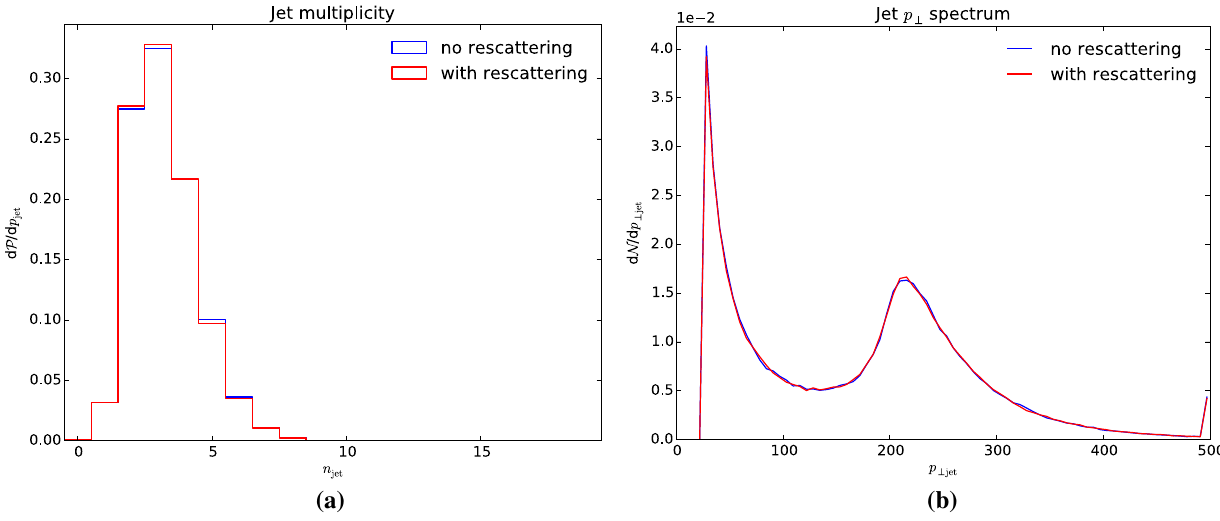
Fig. 9 Production rates ( a ) and inclusive p ⊥ spectra ( b ) of jets in 13 TeV pp collisions, as further described in the text. The uptick in the last bin of b is because all jets with p ⊥ > 500 GeV have been put there